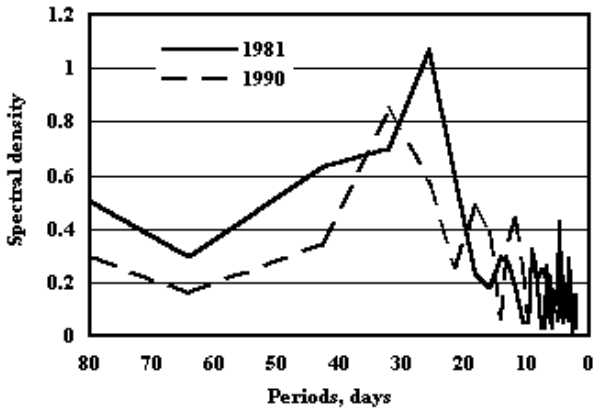
Fig. 5. Examples of typical winter/spring power spectra of total ozone deviations from the intervals 1979–1985 (1981) and 1986– 2000 (1990).